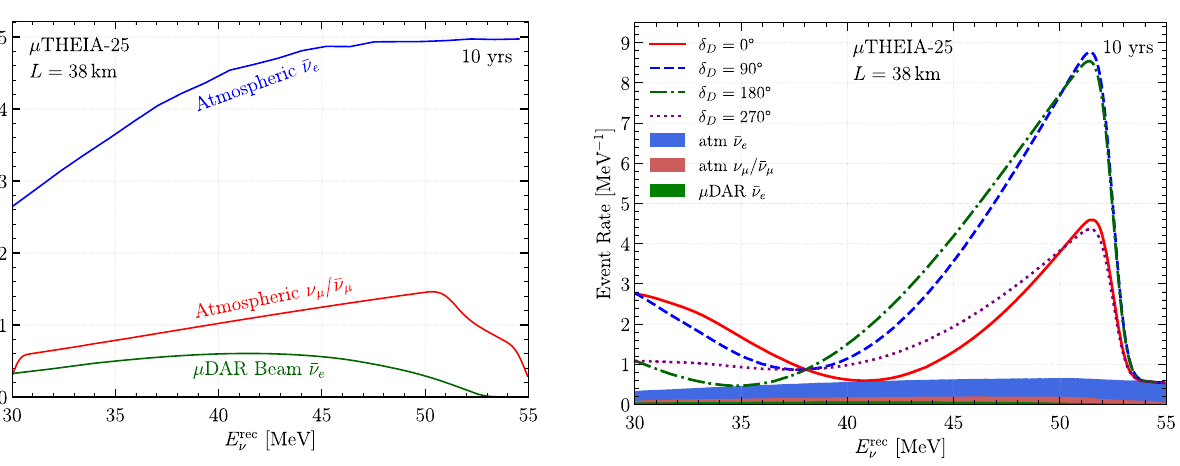
ing both neutron and π + . It has a probability for E vis being within the energy window of interest as shown in Fig. 5.